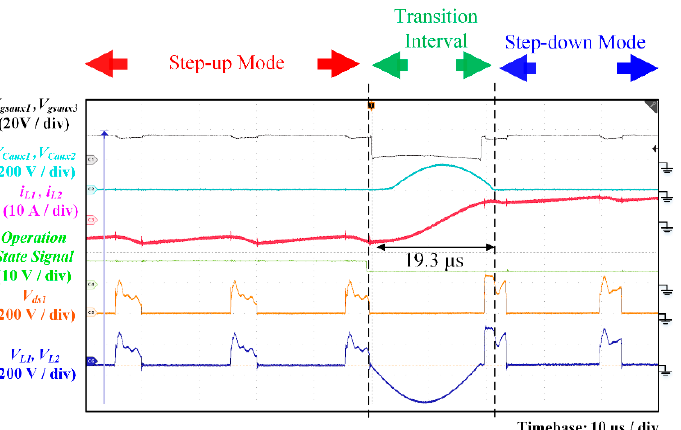
Figure 22. Experimental waveforms of transition from step-down mode to step-up mode under the full-load condition.